Question: Generate an informative caption for the figure above.
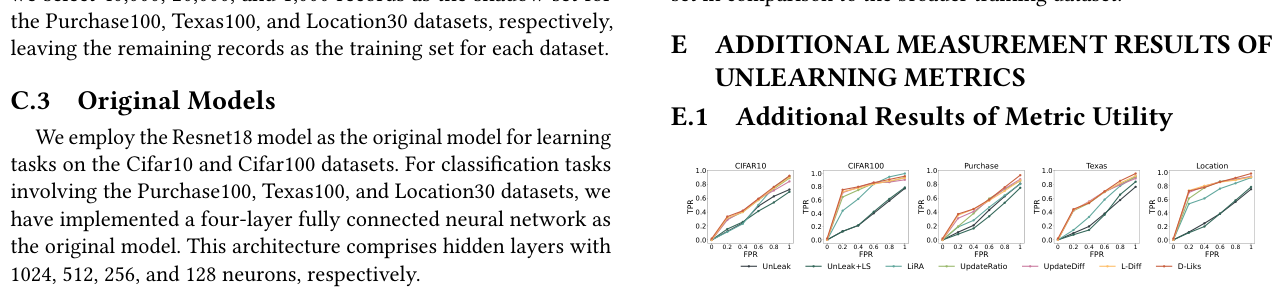
Answer: ROC curves on exact random sample unlearning